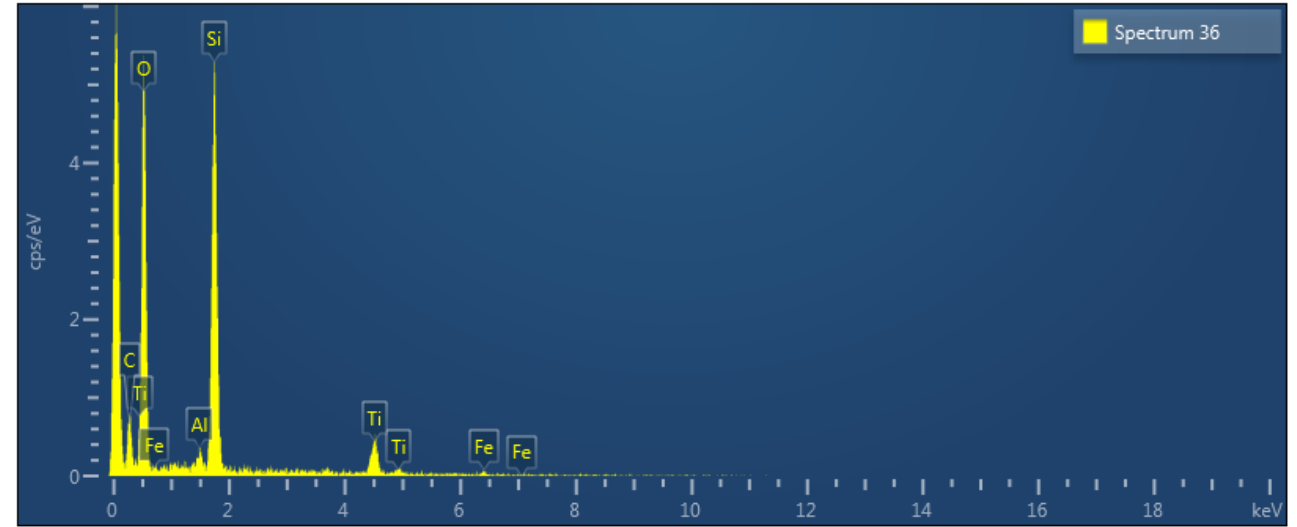
Figure 4. EDX of 20% Li-TiO 2 /feldspar.